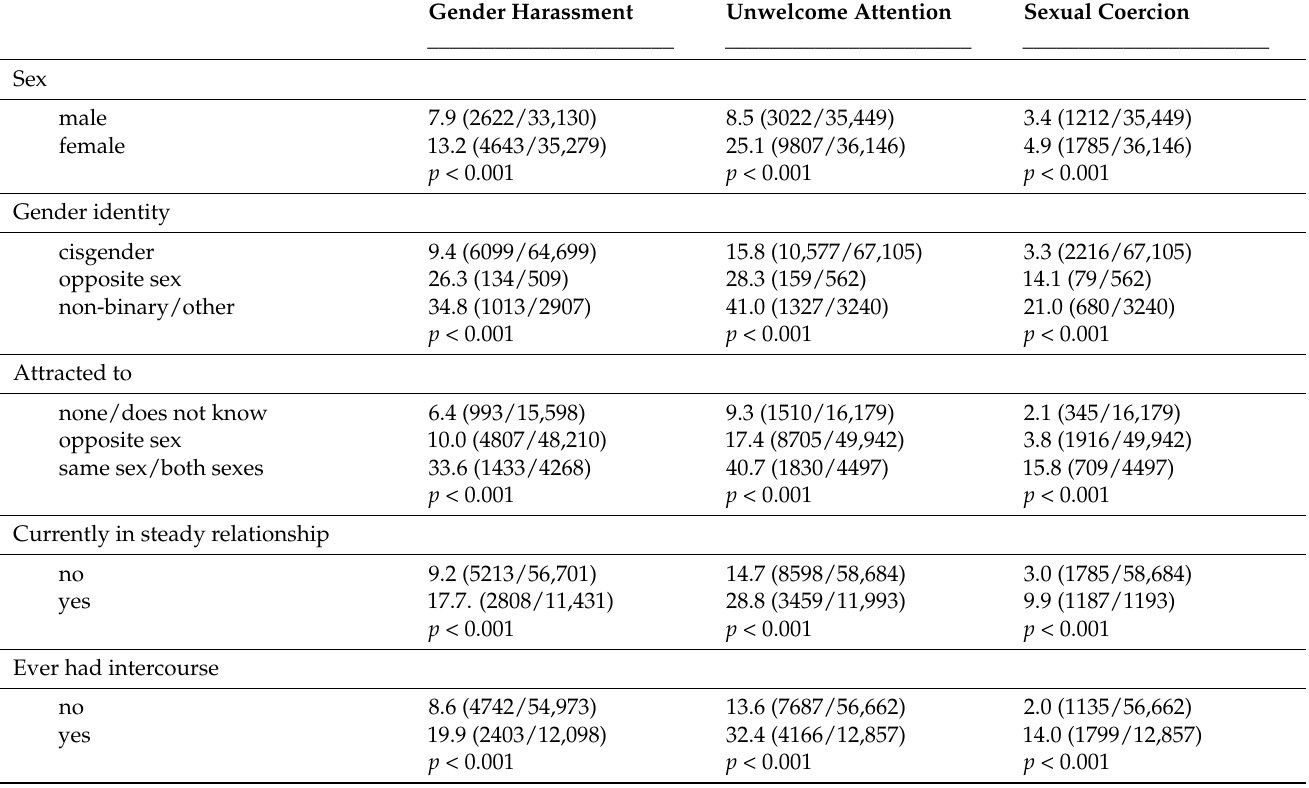
Table 2. Proportions of adolescents reporting experiences of gender harassment, unwelcome sexual attention and sexual coercion according to gender and sexuality related variables (% (n/N)).